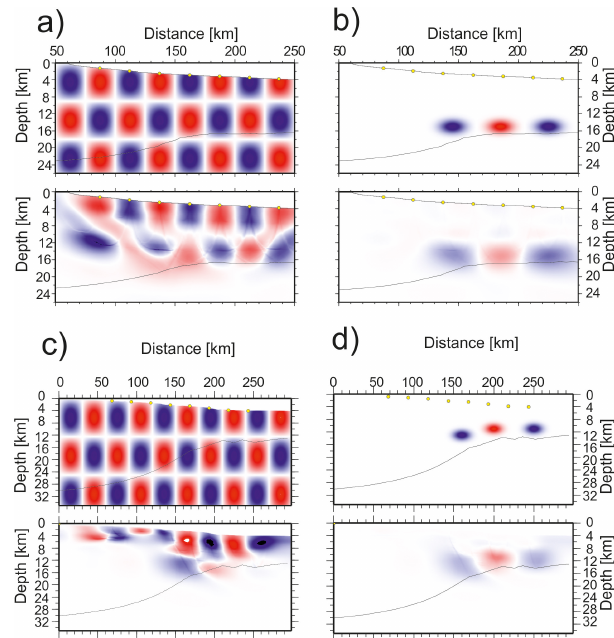
Figure 4. Checkerboard tests of line 1 and line 3. The upper panels represent the applied velocity perturbations and the lower panels the resolved velocities after eight iterations. (a) and (b) are results of line 1. (a) The upper panel shows the relative velocity perturbation of up to 5% in cells of 25 × 9km. The right panels of (b) show that even small elliptical anomalies within the lower part of the crust can be resolved with the data. (c) and (d) Results of line 3. The upper panel of (c) shows the velocity perturbations of 5% in cells of 30 × 12.5. The panels of (d) show the resolution test for elliptical anomalies within the lower part of the